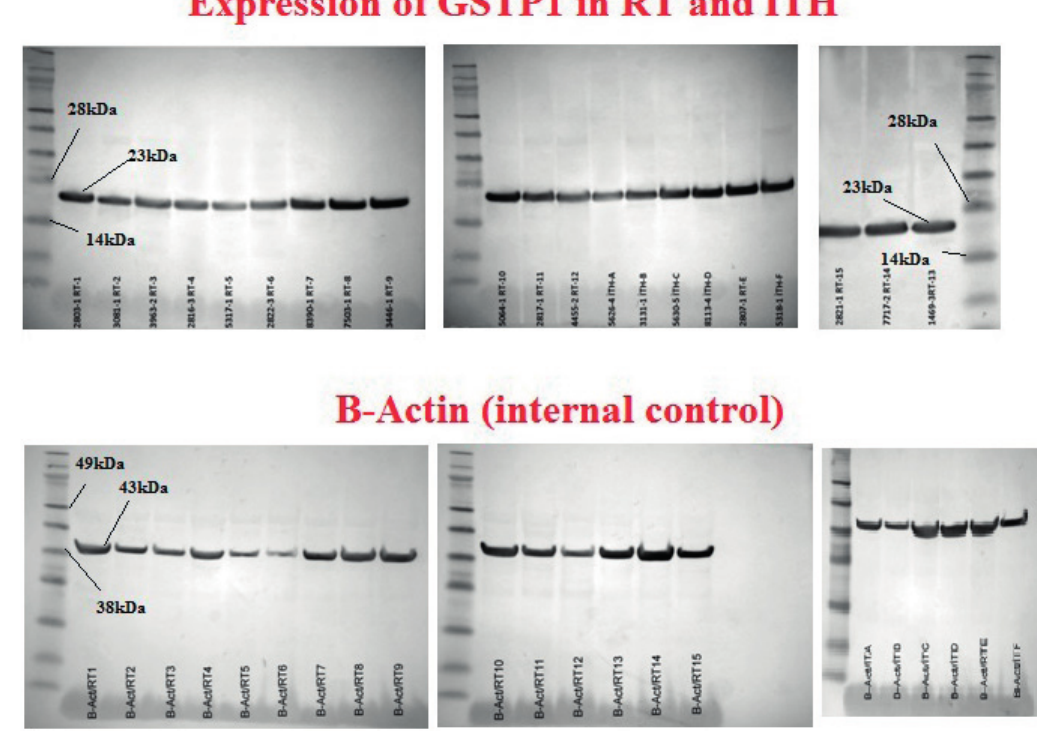
Fig. 3. Immunodetection of GSTP1, B-actin in recurrent tonsillitis and idiopathic tonsillar hypertrophy cyto- solic fractions (∼50 μg protein).